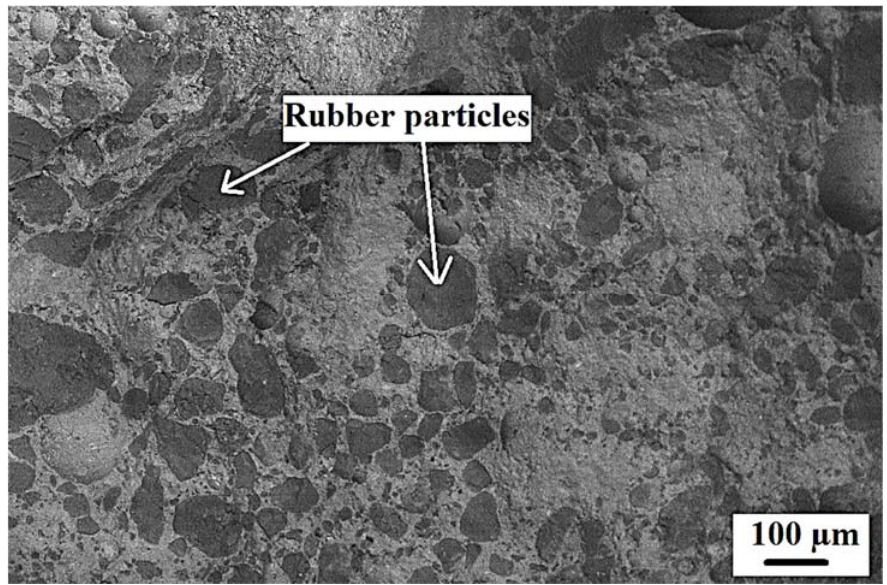
Figure 11. SEM image of concrete specimen incorporating 25% of RW.